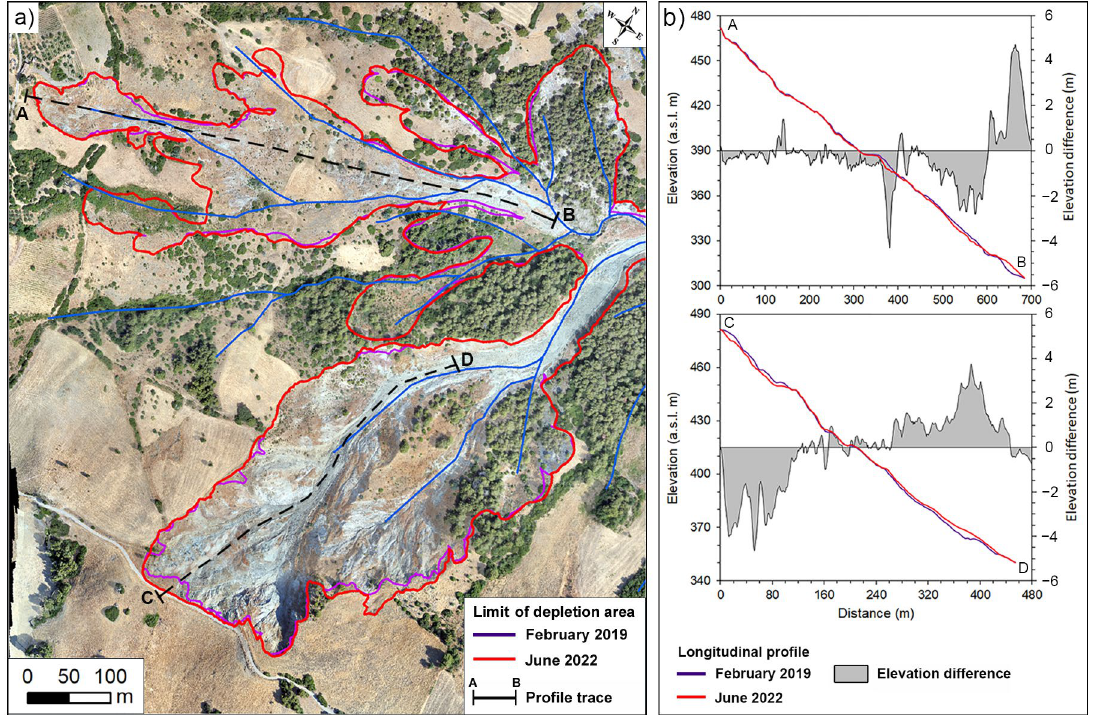
Figure 7. ( a ) Overview of the extension of the depletion zone in February 2019 and June 2022; ( b ) two representative longitudinal profiles extracted from DTMs referring to 2019 and 2022, respectively, illustrating the topographic changes caused by landslides within source areas, producing the retreat and enlargement of the main scarps and the material accumulation downslope.